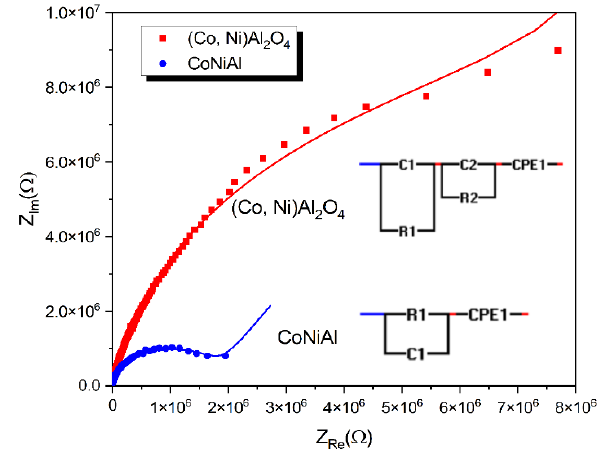
Table 2. Complex impedance analysis.